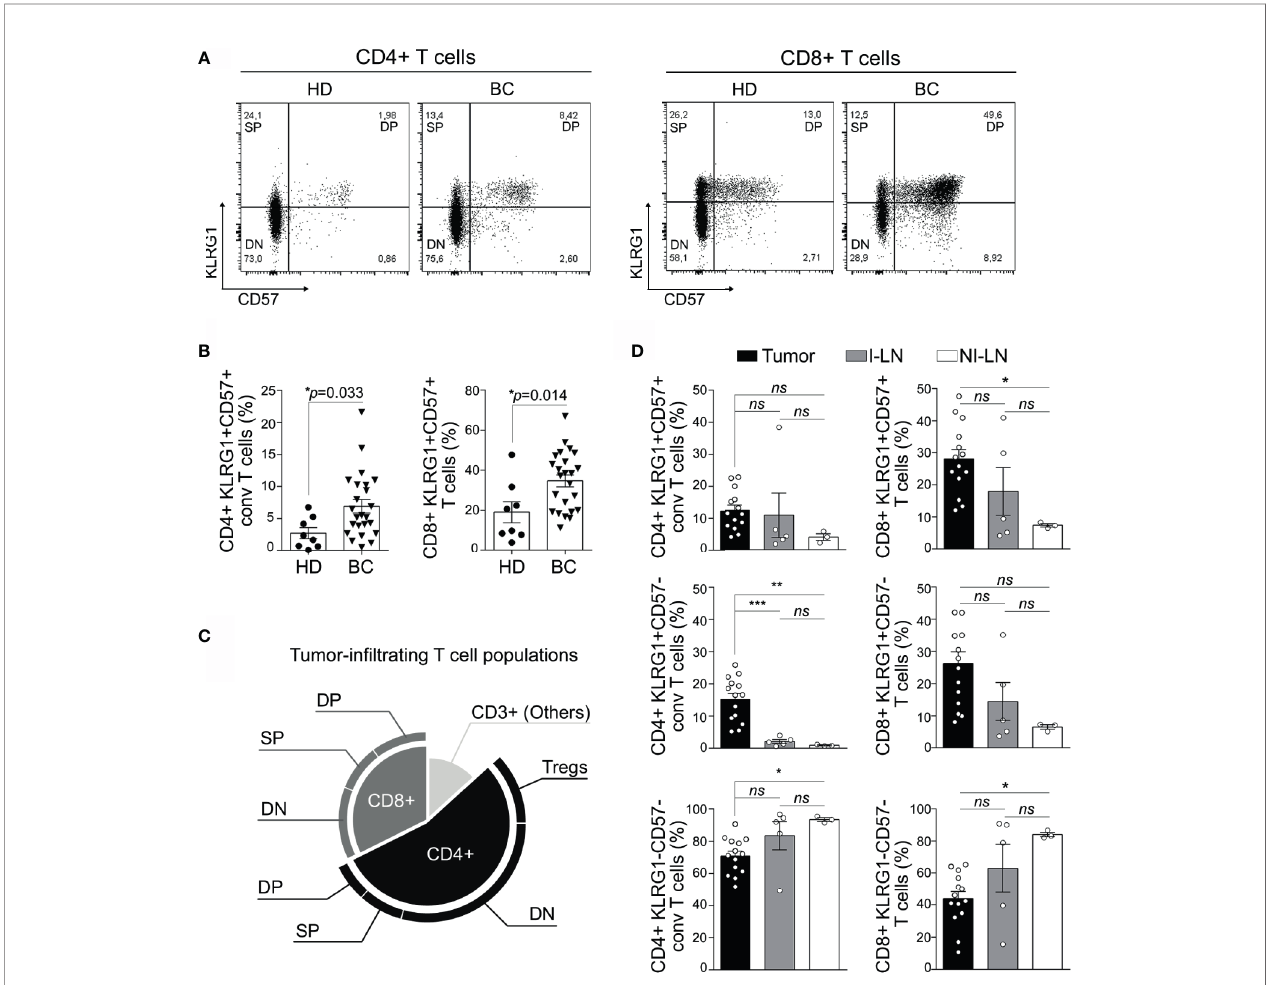
FIGURE 1 | KLRG-1 + CD57 + CD4 + and CD8 + T cells are present in peripheral blood, tumor, and invaded and non-invaded lymph nodes from untreated breast cancer patients. (A) Representative dot plots from one healthy donor (HD) and one breast cancer patient (BC), show the frequency of peripheral blood (PB) CD4 + and CD8 + T cells based on the surface expression of KLRG-1 and CD57 molecules. (B) Bar graphs show frequency of KLRG-1 + CD57 + CD4 + T cells and KLRG- 1 + CD57 + CD8 + T cells from PB of HDs (dots) and BC patients (triangles). Each dot/triangle represents a subject analyzed. Unpaired Student ’ s t -test was used to compare double positive CD4 + or CD8 + T cells in HD vs. BC patients ( p is indicated in each graph). (C) Proportion of CD4 + and CD8 + subsets within tumor- in fi ltrating CD3 + population. (D) Bar graphs show mean frequency (± SEM) of KLRG-1 + CD57 + (DP), KLRG-1 + CD57 − (SP), KLRG-1 − CD57 − (DN) within conventional CD4 + (left panel) or CD8 + (right panel) T cells in tumor (black), invaded lymph nodes I-LN (gray) and non-invaded LN, NI-LN (white). One-way ANOVA with Sidak ’ s post-test was applied. *p < 0.05, **p < 0.01, ***p < 0.001, ns, not signi fi